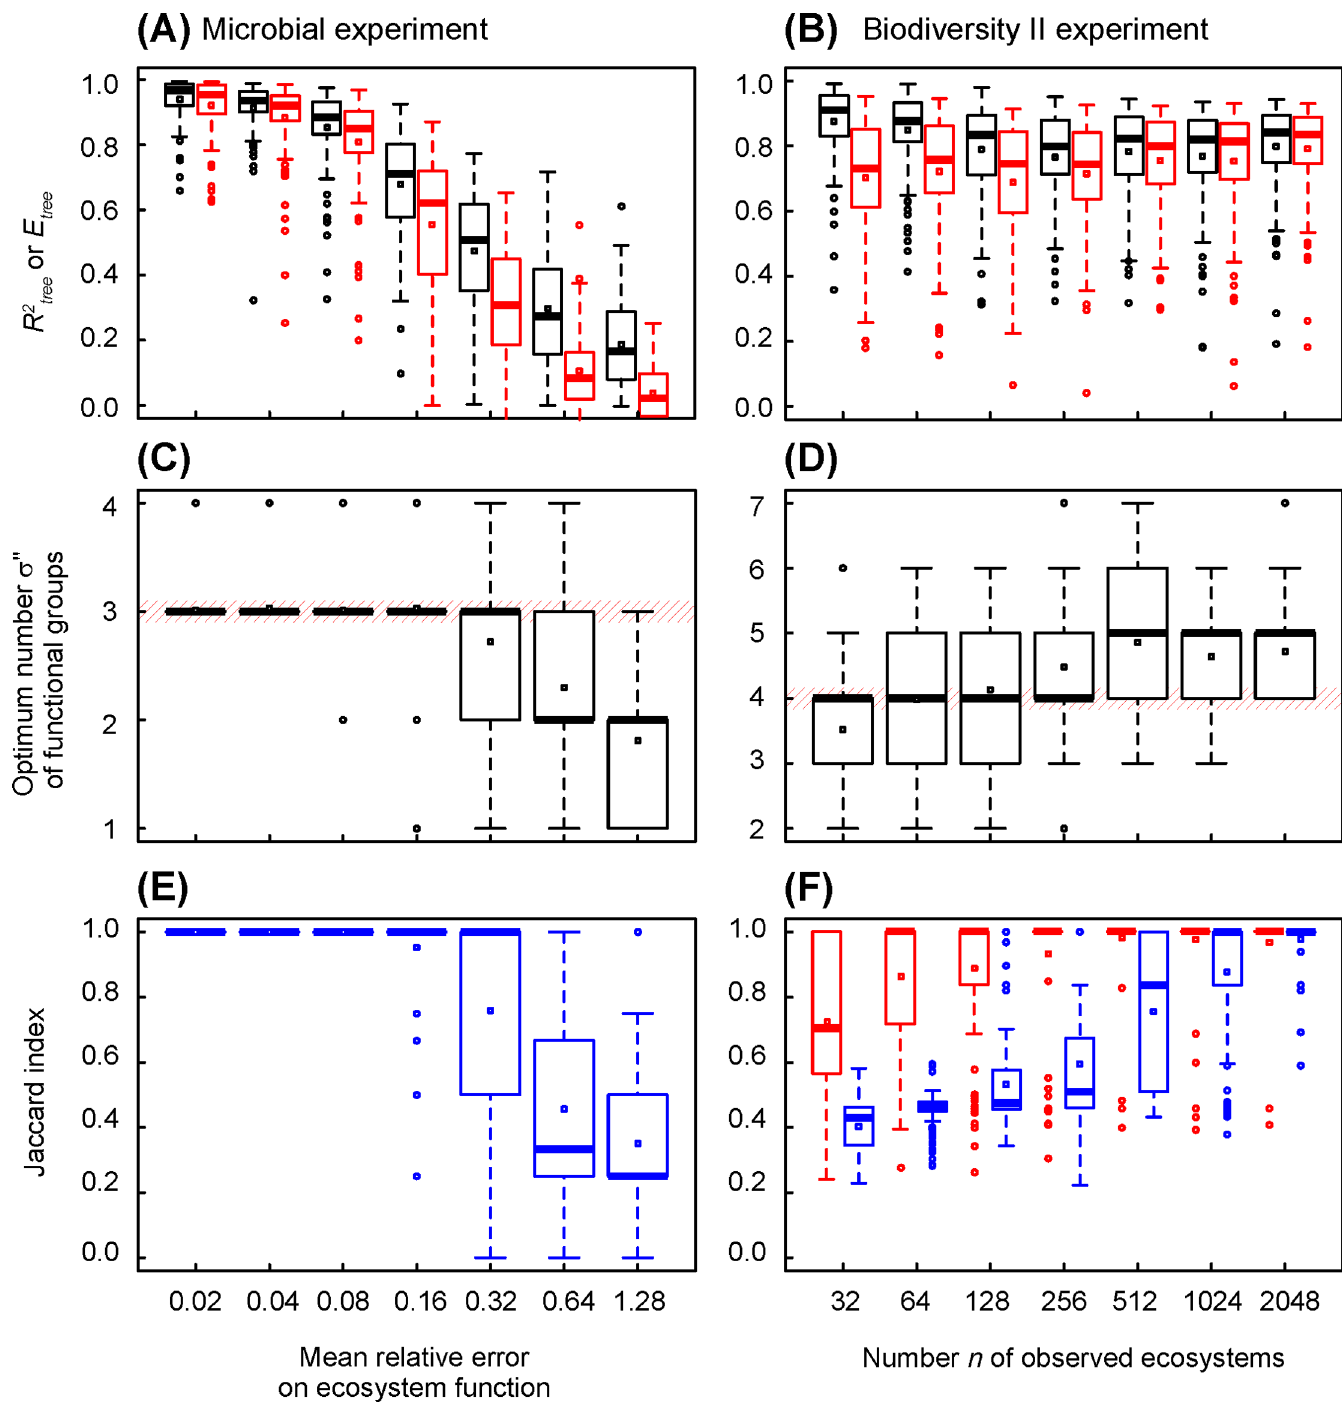
Fig 5. Changes in coefficient of determination, efficiency, optimum number of functional groups and Jaccard index in simulated datasets, versus relative error of ecosystem function and number of observed ecosystems. (A), (C) and (E) Simulated dataset mimicking the microbial experiment of Langenheder et al. [16]. All ecosystems are observed and the mean relative error increases from 0.02 to 1.28. The statistics describe 100 datasets randomly generated. (B), (D) and (F) Simulated dataset mimicking the Biodiversity II experiment of Tilman et al. [17]. The mean relative error is 0.17 and the number of observed ecosystems increases from 32 to 2048. The statistics describe 100 random sampling from a same random dataset. (A) and (B) Tree coefficient of determination (in black) and efficiency (in red). (C) and (D) Optimum number of functional groups indicated by tree AICc. (E) and (F) Jaccard index. In blue, by referring to the number of functional groups a priori defined (3 and 4 in microbial and Biodiversity II experiments, respectively). In red, by referring to 3 functional groups in Biodiversity II experiment, resulting from the clustering of the two largest species functional groups. https://doi.org/10.1371/journal.pone.0203681.g002 PLOS ONE | https://doi.org/10.1371/journal.pone.0203681 September 5,